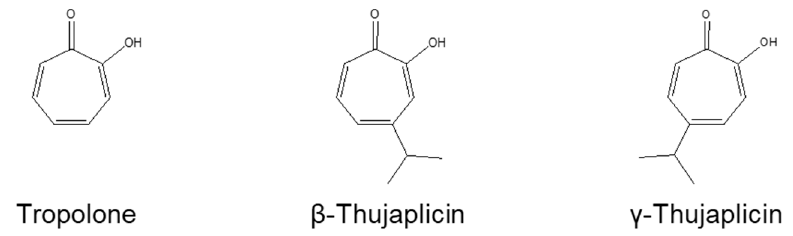
Figure 1. The structures of tropolone, β -thujaplicin, and γ -thujaplicin.